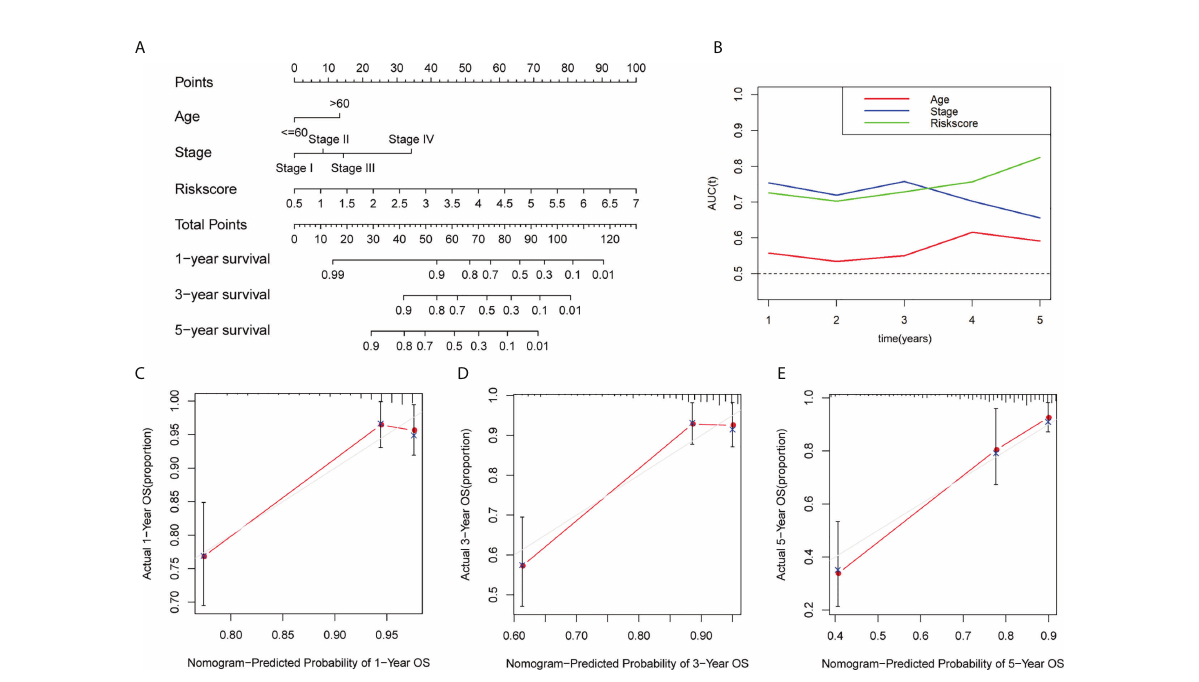
FIGURE 6 Construction and calibration of the nomogram. (A) Construction of a nomogram based on age, stage, and risk score as independent prognostic factors. (B) Time-dependent ROC analysis based on the nomogram and clinical characteristics. (C – E) The calibration plot for internal validation of the nomogram within 1, 3, and 5 years, respectively. AUC, the area under the ROC